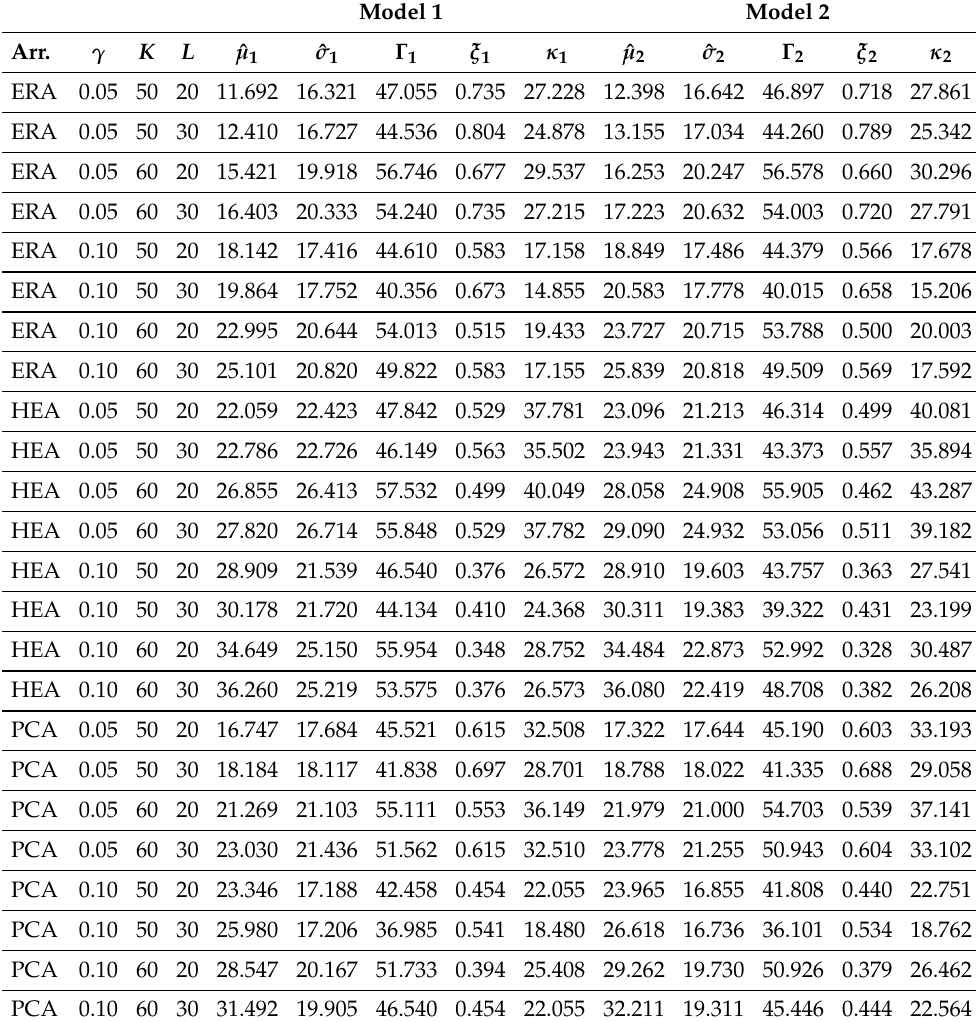
Table 2. Inventory subsystem— µ = 1.1,